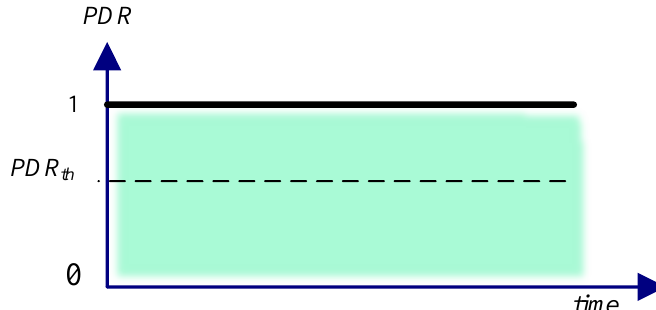
Figure 5. Resiliency curve of the SCN model for Case-I .